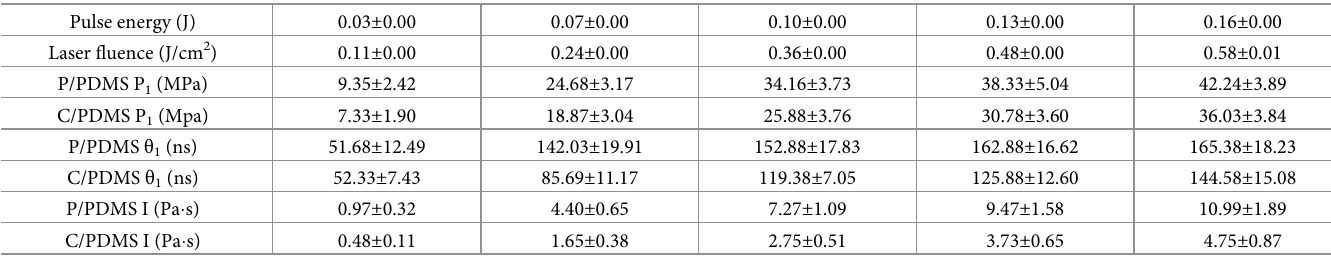
Table 1. Summary of pressure measurements.